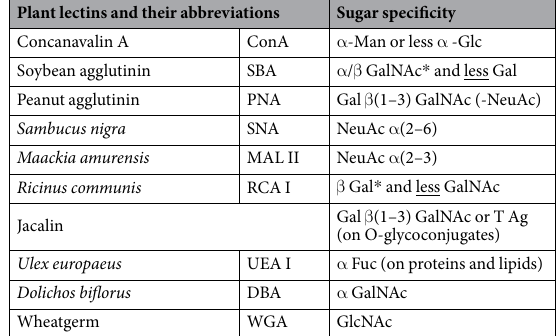
Table 2. Plant lectins used in this study. * In a terminal